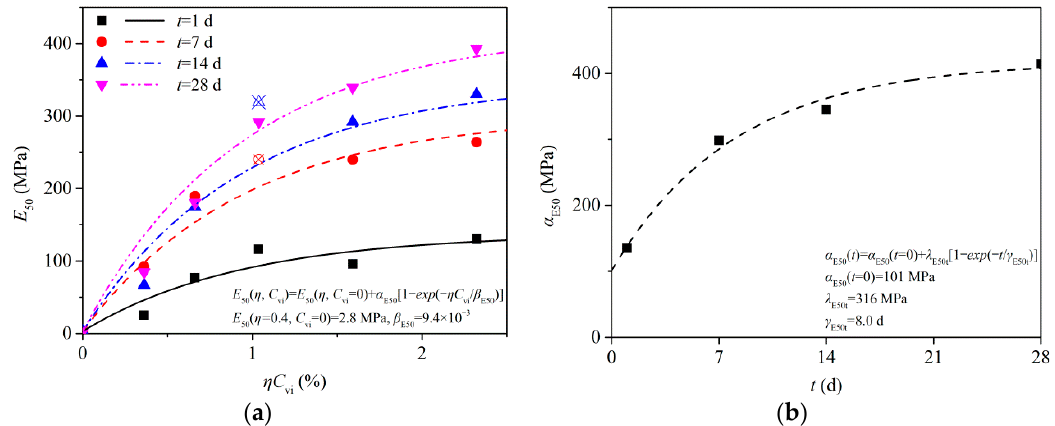
Figure 18. Modeling of E 50 of saturated cement-treated GRS (Hollow symbol with cross indicates